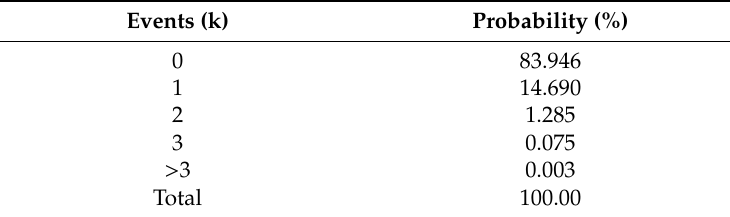
Table 3. Number of events in one year under a Poisson process.